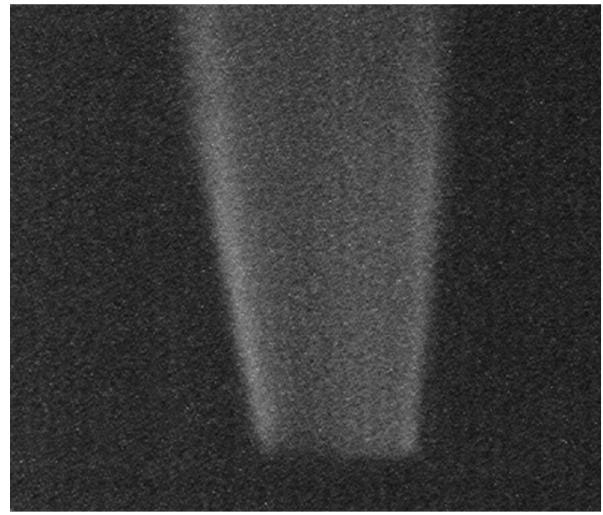
Figure 9. UV image of hydrogen gas extracted by an UV optical filter system.